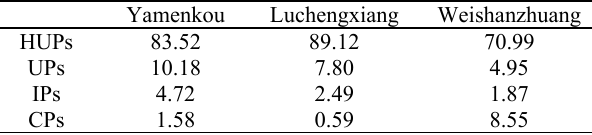
Table 6. Volume proportion (%) of different classes in sample selection.